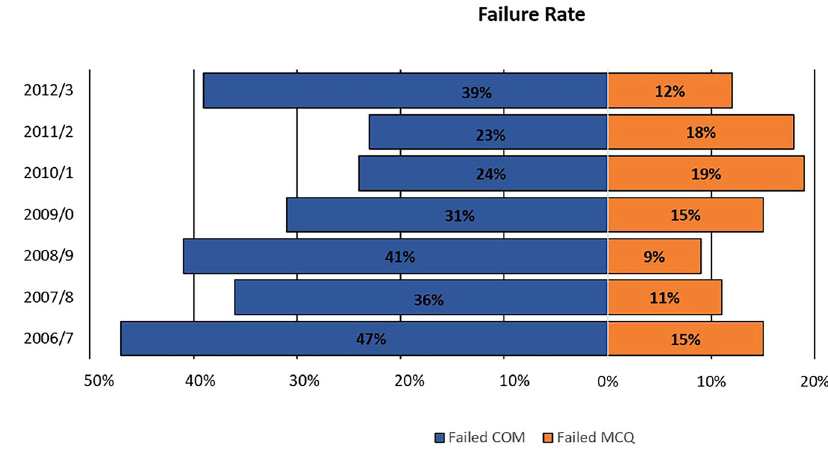
Fig. 1 Failure rate of learners (2006 – 2013). Results from analysis of student failure rates for computational